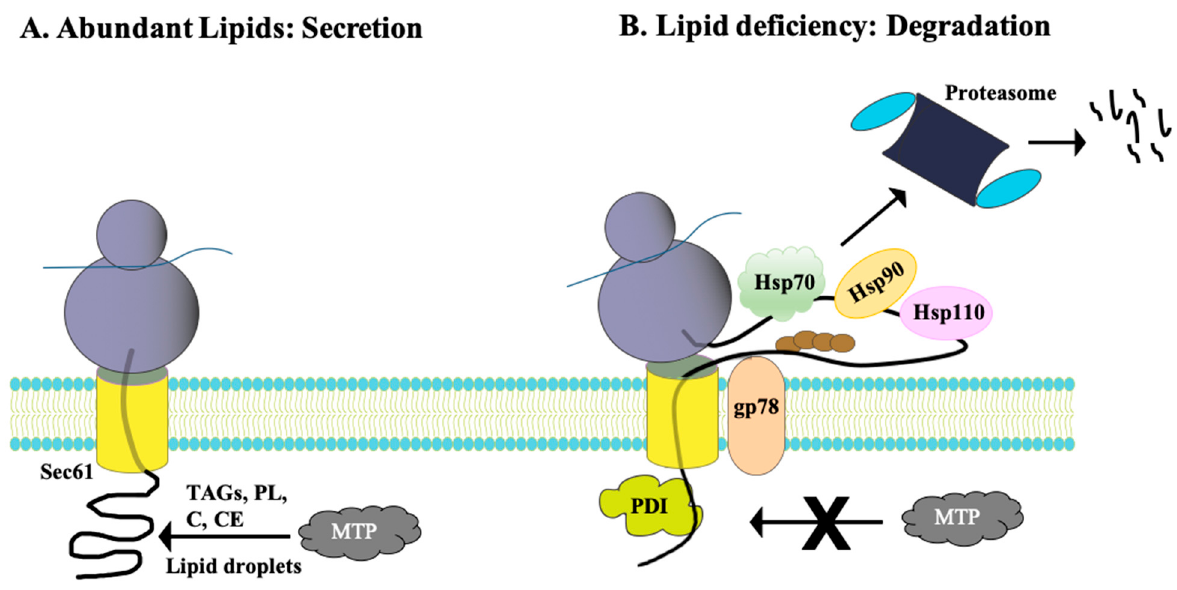
Figure 3. Early steps during apolipoprotein B (ApoB) biosynthesis. ( A ) Under lipid-rich conditions, cholesterol (C), cholesterol esters (CE), phospholipids (PL), and triacylglycerides (TAG) from the ER membrane and from ER lumenal lipid droplets assemble onto ApoB with the assistance of the MTP complex as it is co-translationally translocated through Sec61. ( B ) Under lipid-poor conditions, co-translational translocation through Sec61 slows but translation continues, depositing large polypeptide segments of ApoB in the cytoplasm. The depicted chaperones, as well as the gp78 ubiquitin ligase, associate with and facilitate ApoB targeting the proteasome.